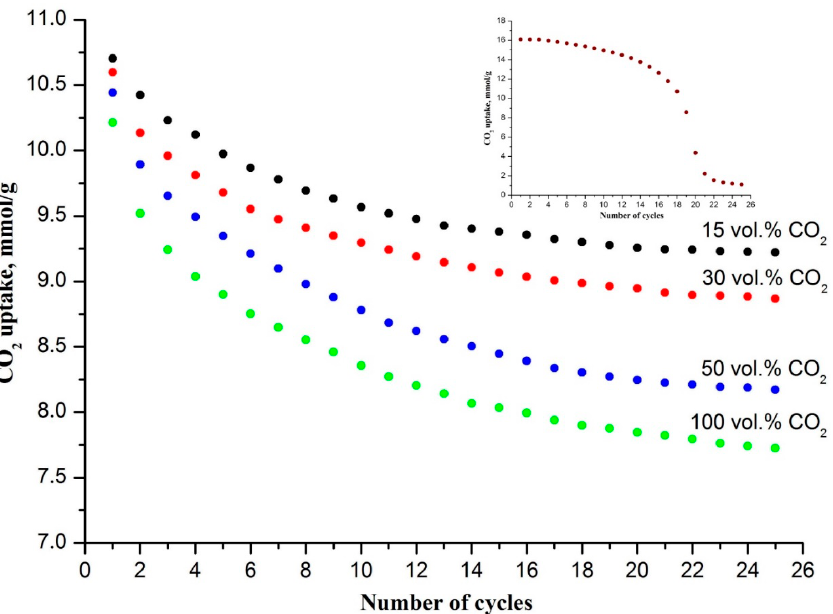
Figure 2. The dependencies of the sorbent CO 2 uptake capacity on the number of carbonation– decarbonation cycles at different CO 2 concentrations in the gas flow upon carbonation. The insert shows the dependence of zirconium-undoped sorbent CO 2 uptake capacity on the number of carbonation–calcination cycles at 15 vol.% CO 2 in the gas flow upon